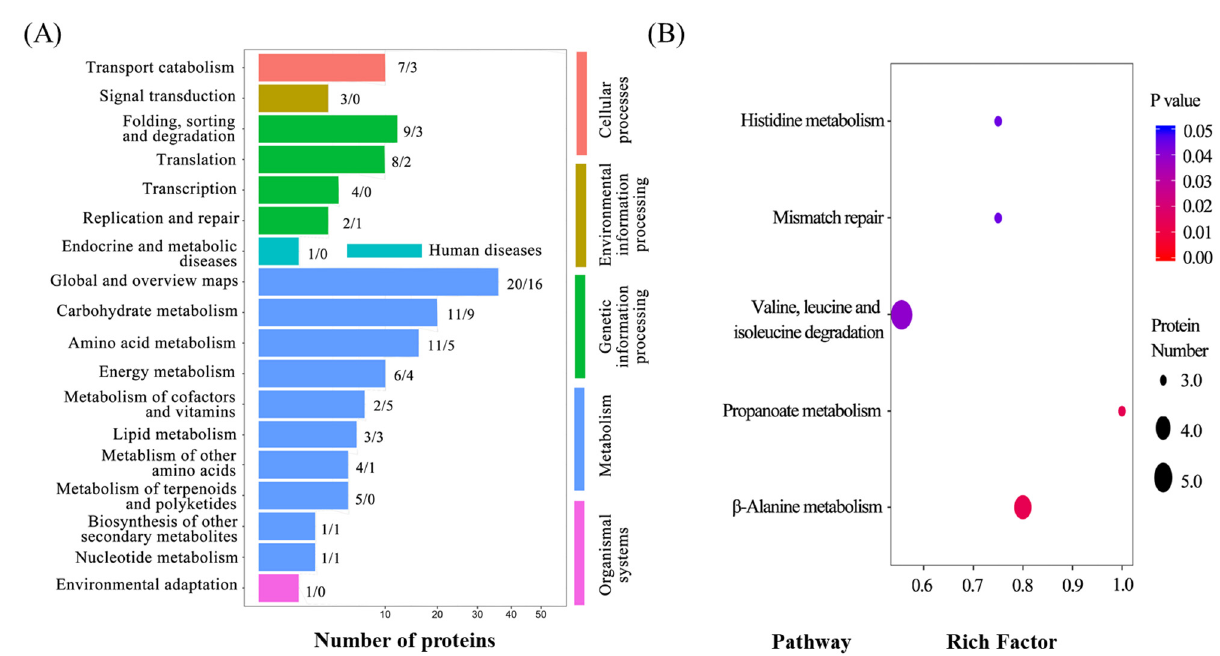
Figure 5. Functional classification ( A ) and pathway enrichment analysis ( B ) of differentially expressed proteins of seeds in Cixidabaican vs. Lingxiyicun. Proteins were identified by iTRAQ-based proteomic analysis, and were classified according to KEGG functional classifications.